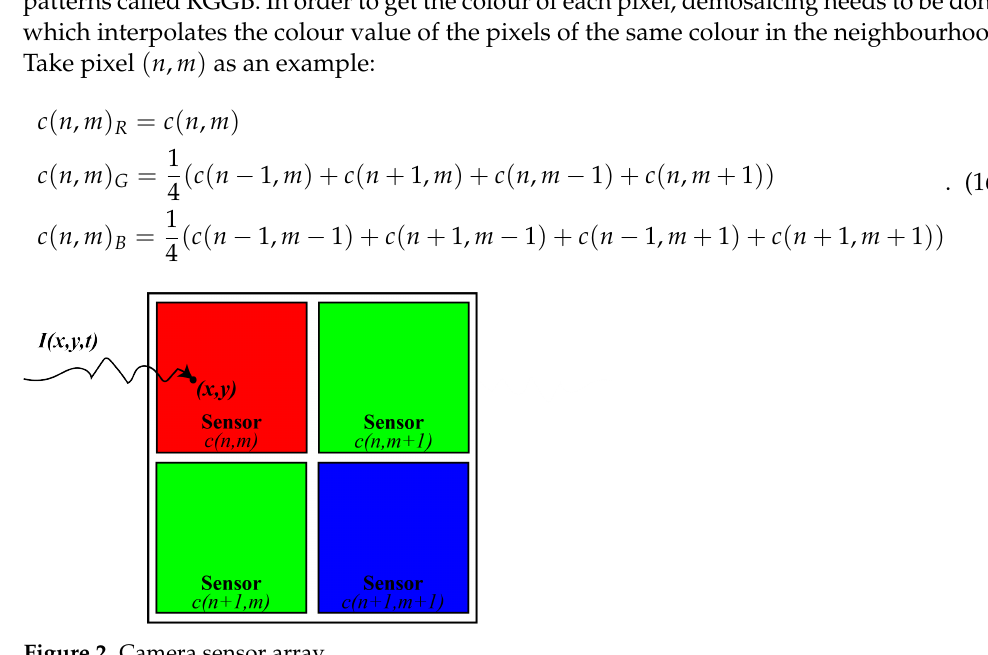
Figure 2. Camera sensor